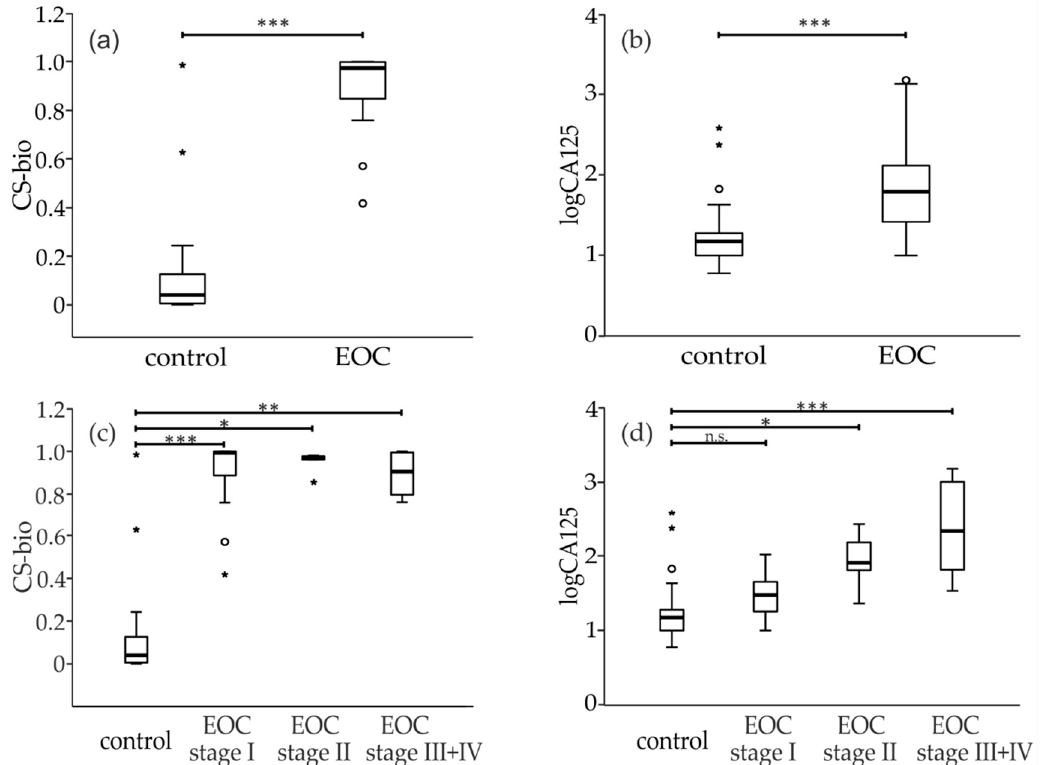
Figure 3. Boxplots were performed for CS-bio and logarithmic values of CA125. In ( a , b ), the whole cohort was considered in the EOC group. In ( c , d ), the EOC cohort was divided according to stages. The Bonferroni corrected p -values (* p < 0.5, ** p < 0.01, *** p < 0.001, n.s. non-significant) were estimated from non-parametric multiple pairwise comparison Jonckh eere–Terpstra test (T JT ).